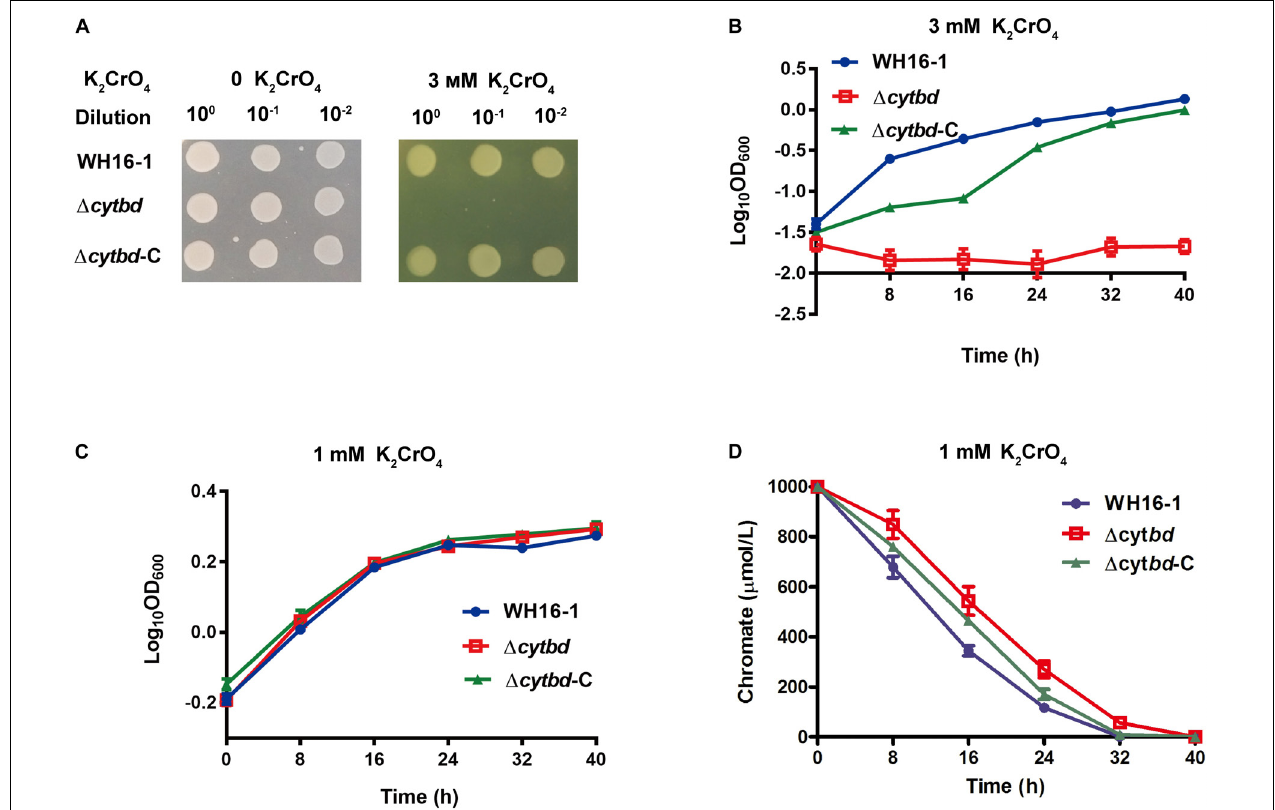
FIGURE 3 | Effects of Cytbd on chromate resistance and reduction. (A) The growth of WH16-1 (wild type), (cid:77) cytbd (mutant strain), and (cid:77) cytbd -C (complemented strain) with 0 or 3 mM K 2 CrO 4 on an LB medium plate. (B) The growth curve of WH16-1, (cid:77) cytbd , and (cid:77) cytbd -C with 3 mM K 2 CrO 4 in LB medium. K 2 CrO 4 was added at the beginning ( A and B ). The growth (C) and K 2 CrO 4 reduction (D) curves of WH16-1, (cid:49) cytbd , and (cid:49) cytbd -C with 1 mM K 2 CrO 4 in LB medium. To maintain similar growth conditions, K 2 CrO 4 was added until OD 600 reached 0.6 ( C and D ). Every sample was prepared in triplicate, and the results are presented as the mean